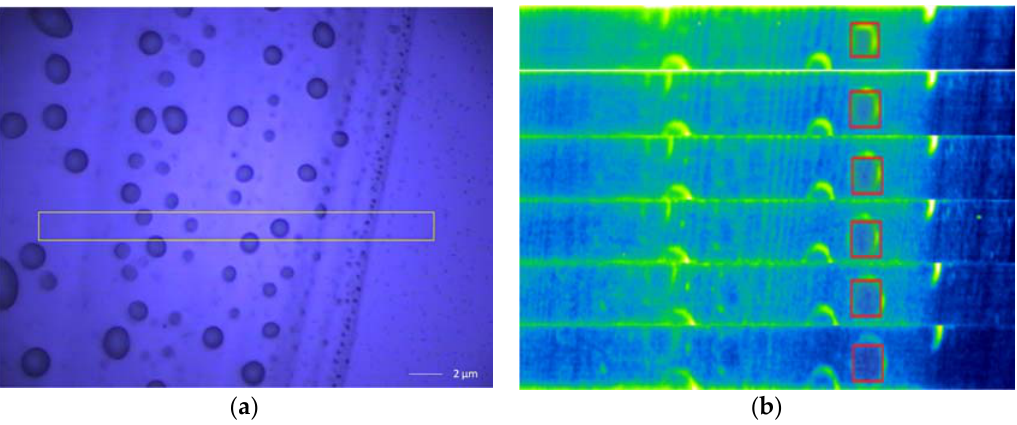
Figure 2. 3D-Raman microscopic image of high-pressure homogenous preparation of nanoemulsions. In